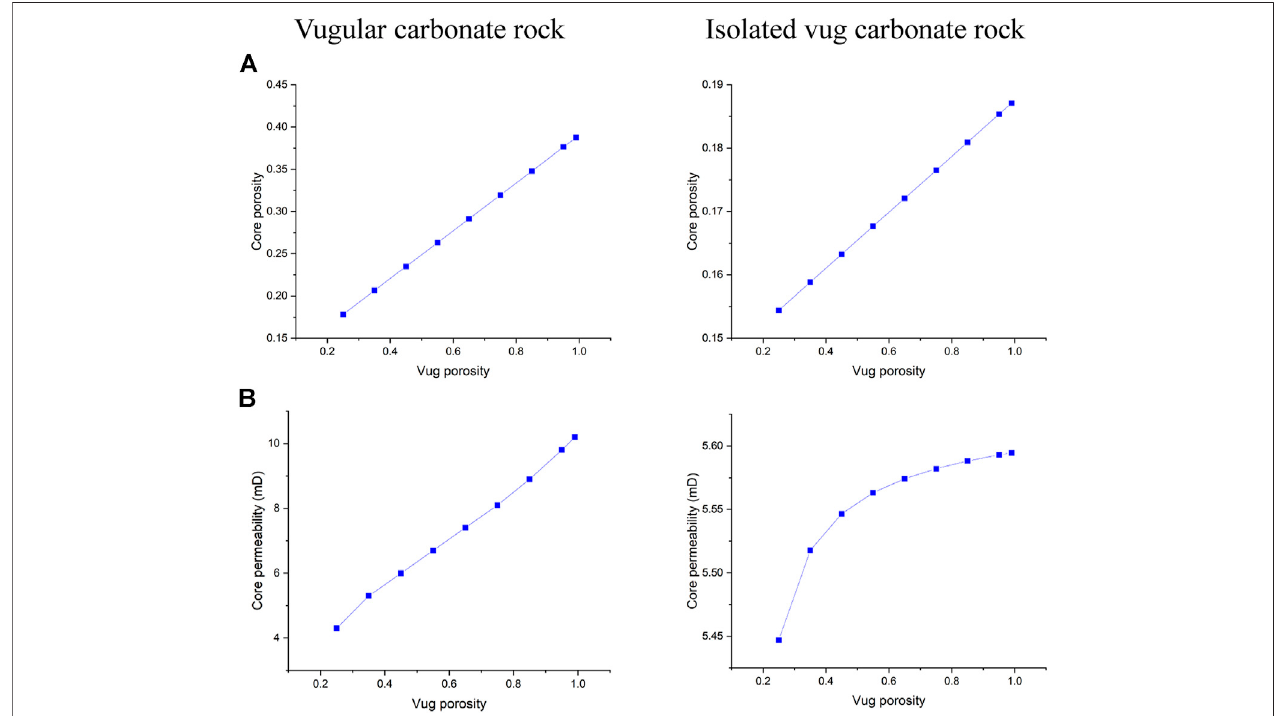
FIGURE 8 | Effect of vug porosity on core physical parameters: (A) core porosity and (B) core permeability.